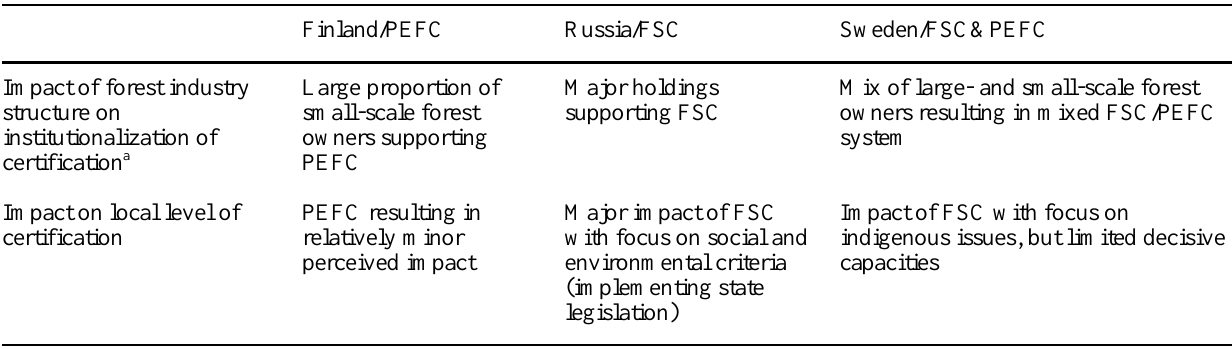
Table 3. Explaining variation in institutionalization and perception of certification